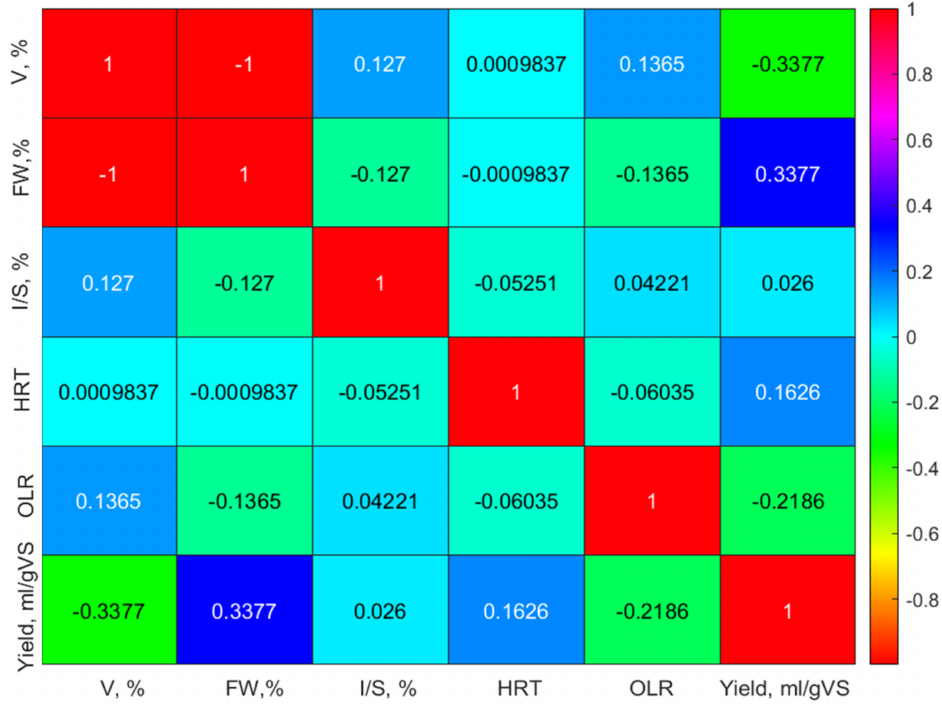
Figure 5. Correlation heatmap.